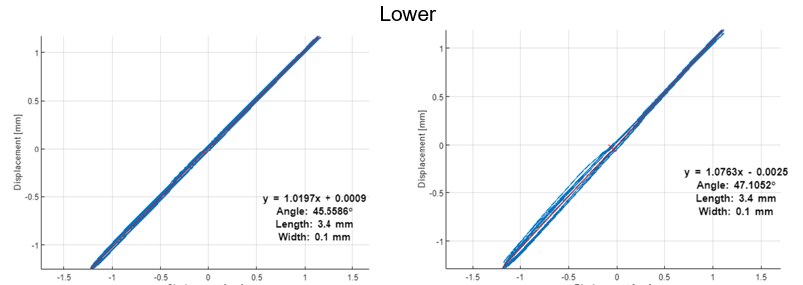
Figure 15. Orbits after repair.